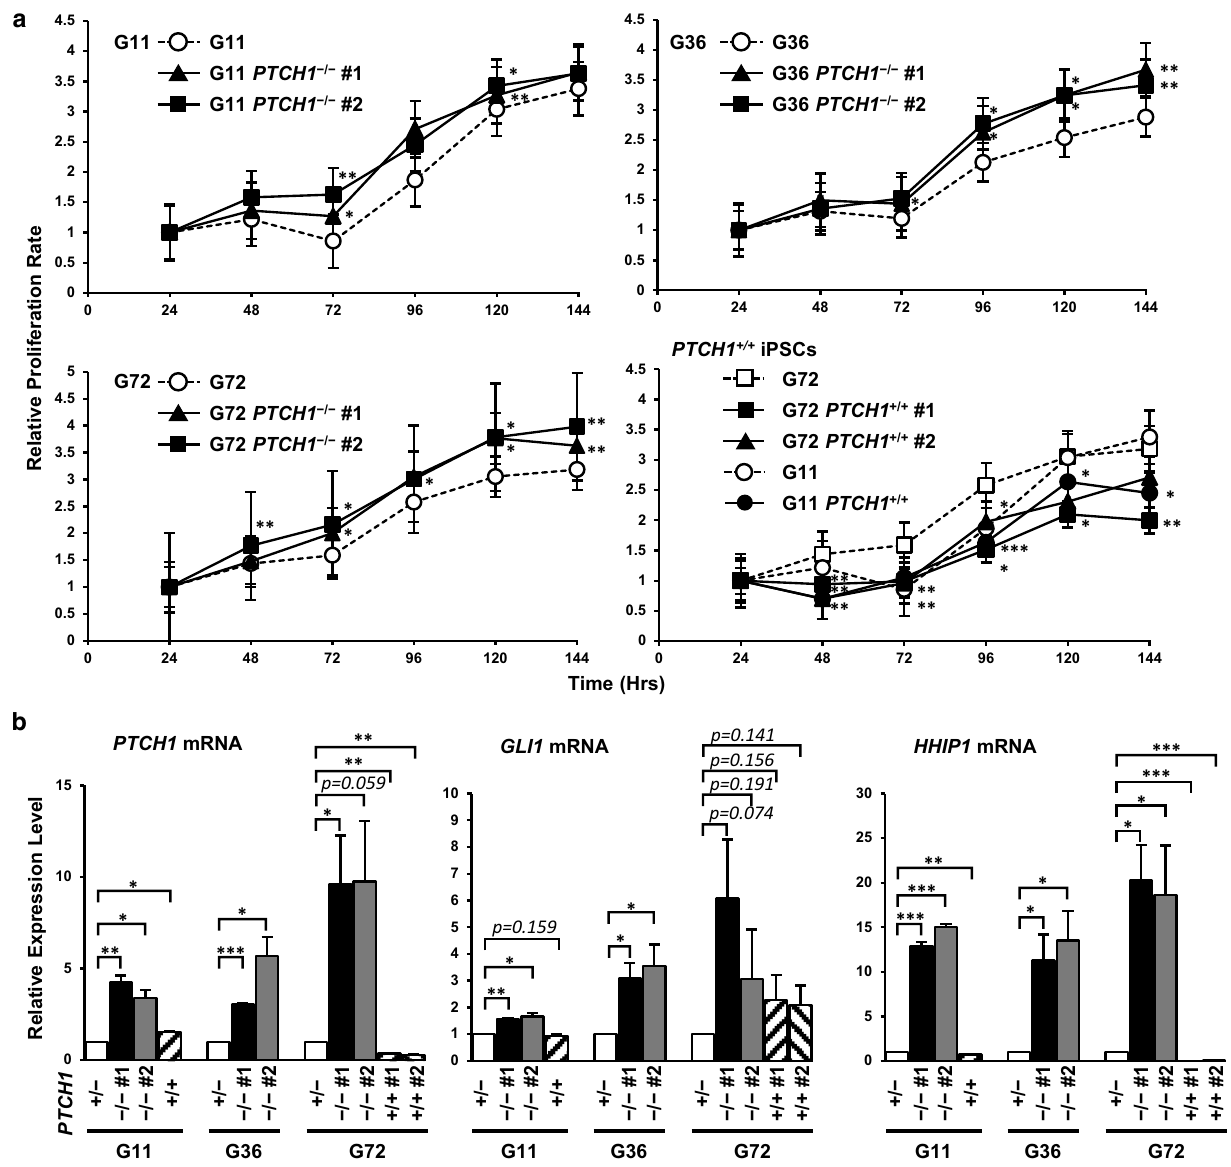
Fig. 2 Hh signaling was accelerated in PTCH1 −/− iPSC lines. a Cell proliferation assay of PTCH1 -edited iPSCs. Eight hundred cells were plated on a 96-well plate and cell numbers were measured every 24 h using the BrdU incorporation assay. b The expression levels of the Hh-signal- ing target genes, PTCH1 , GLI1 , and HHIP1 were normalized by GAPDH mRNA levels. Data are presented as means ± SEM ( n = 3 ). *: p < 0.05, **: p < 0.01, ***: p <